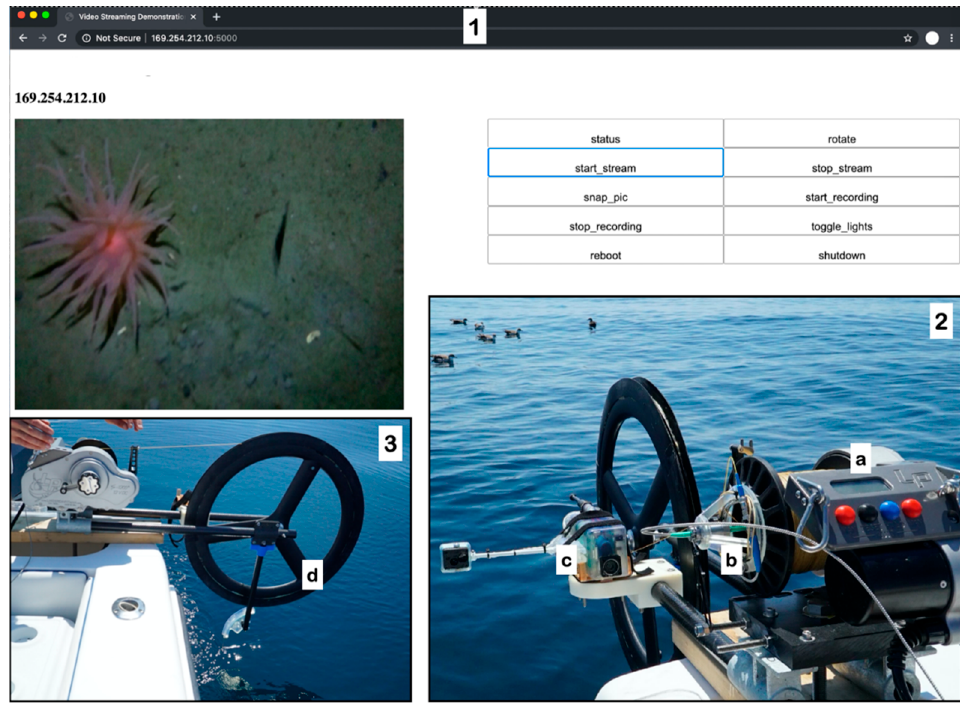
Figure 3. Deepwater field trials of the FOReelS system. ( 1 ) Screenshot of live video stream from approximately 350 m as the FOReelS is used to explore Atlantis Canyon in August 2020, including control GUI running on a Google Chrome browser window. ( 2 ) FOReelS system mounted on the transom of a 31 ′ center console fishing vessel, used for the Atlantis Canyon deepwater field trials; ( a ) commercial off-the-shelf electric fishing reel; ( b ) fiber optic slip-ring and custom 3D-printed mount; ( c ) DPS, prepared for deployment. ( 3 ) Side view of FOReelS mid-deployment showing ( d ) carbon fiber wheel used to increase the bending radius of the overboarding sheave.